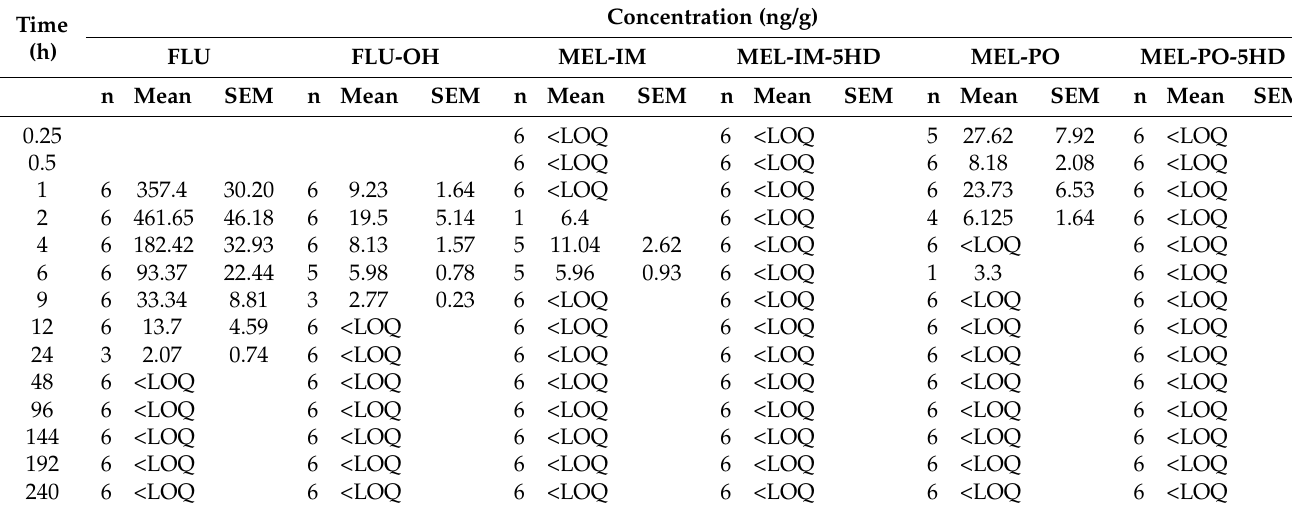
Figure 3. Mean ± SEM parent drug concentration in tissue after administration of a single dose of meloxicam (1 mg/kg) orally ( A ) or intramuscularly ( B ) (n = 6) from 0 to 12 h post-administration in tilapia.